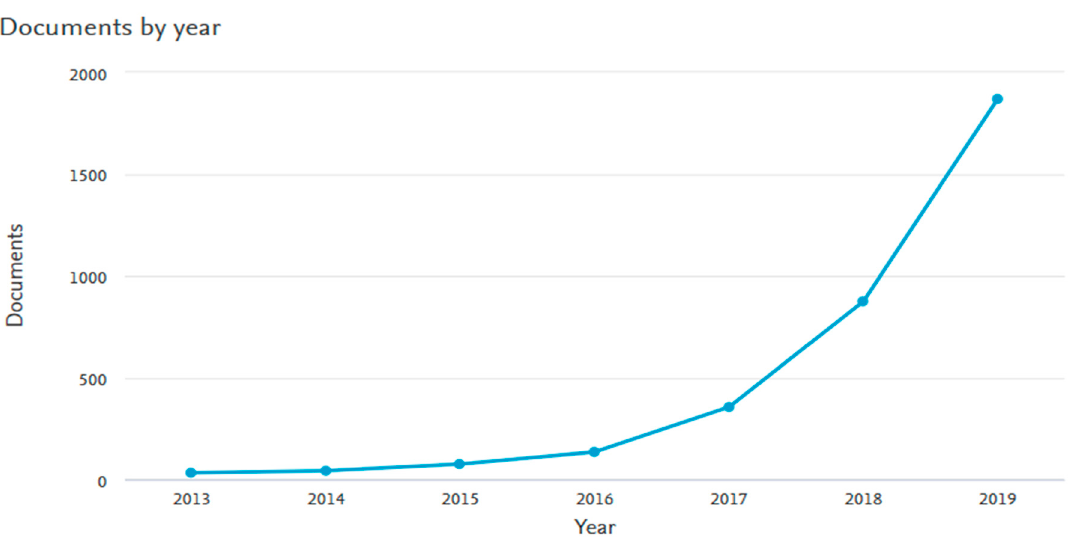
Figure 1. Rapid rise in the applications of data science in economics.